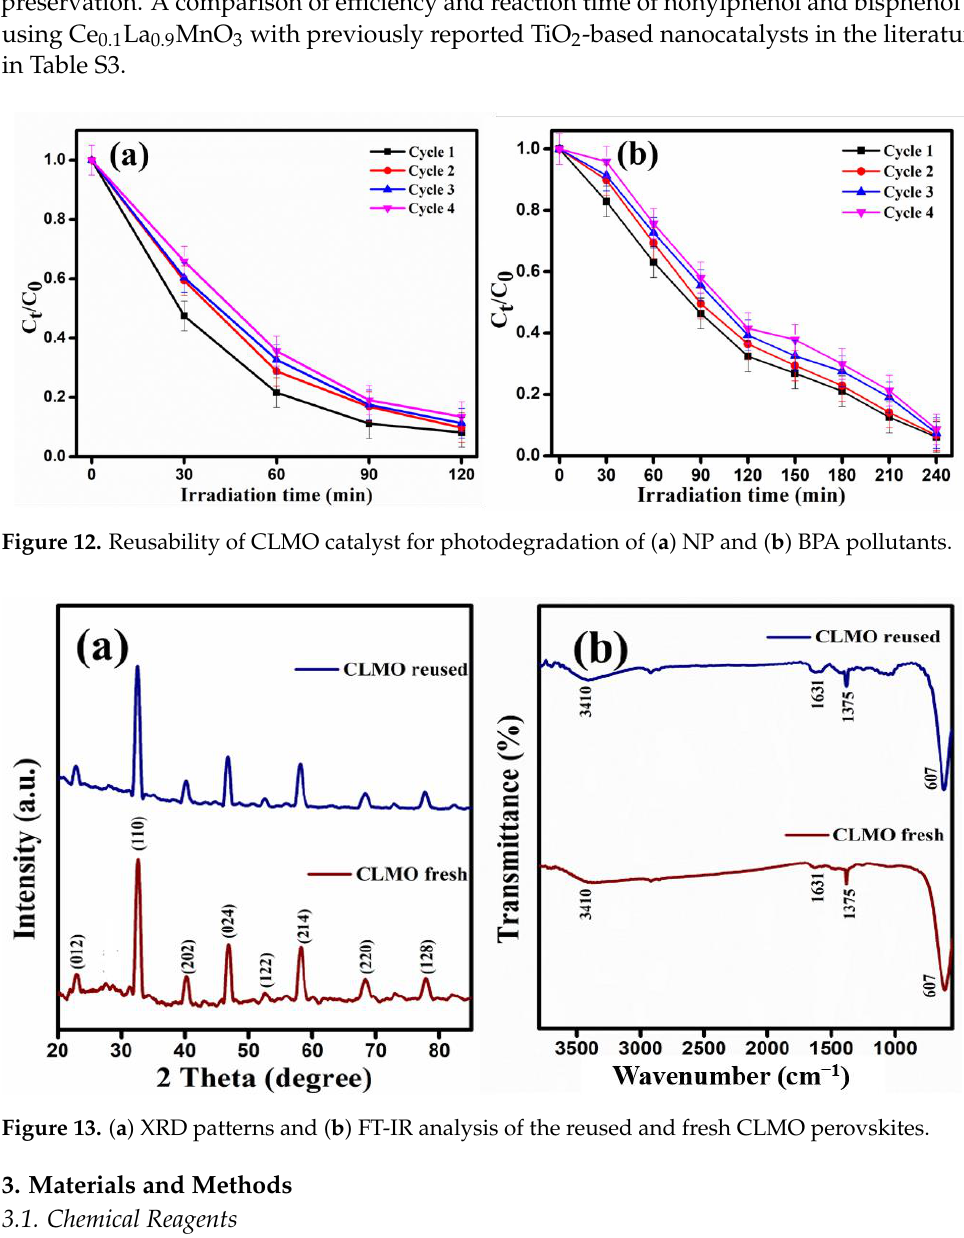
Figure 13. ( a ) XRD patterns and ( b ) FT-IR analysis of the reused and fresh CLMO perovskites.